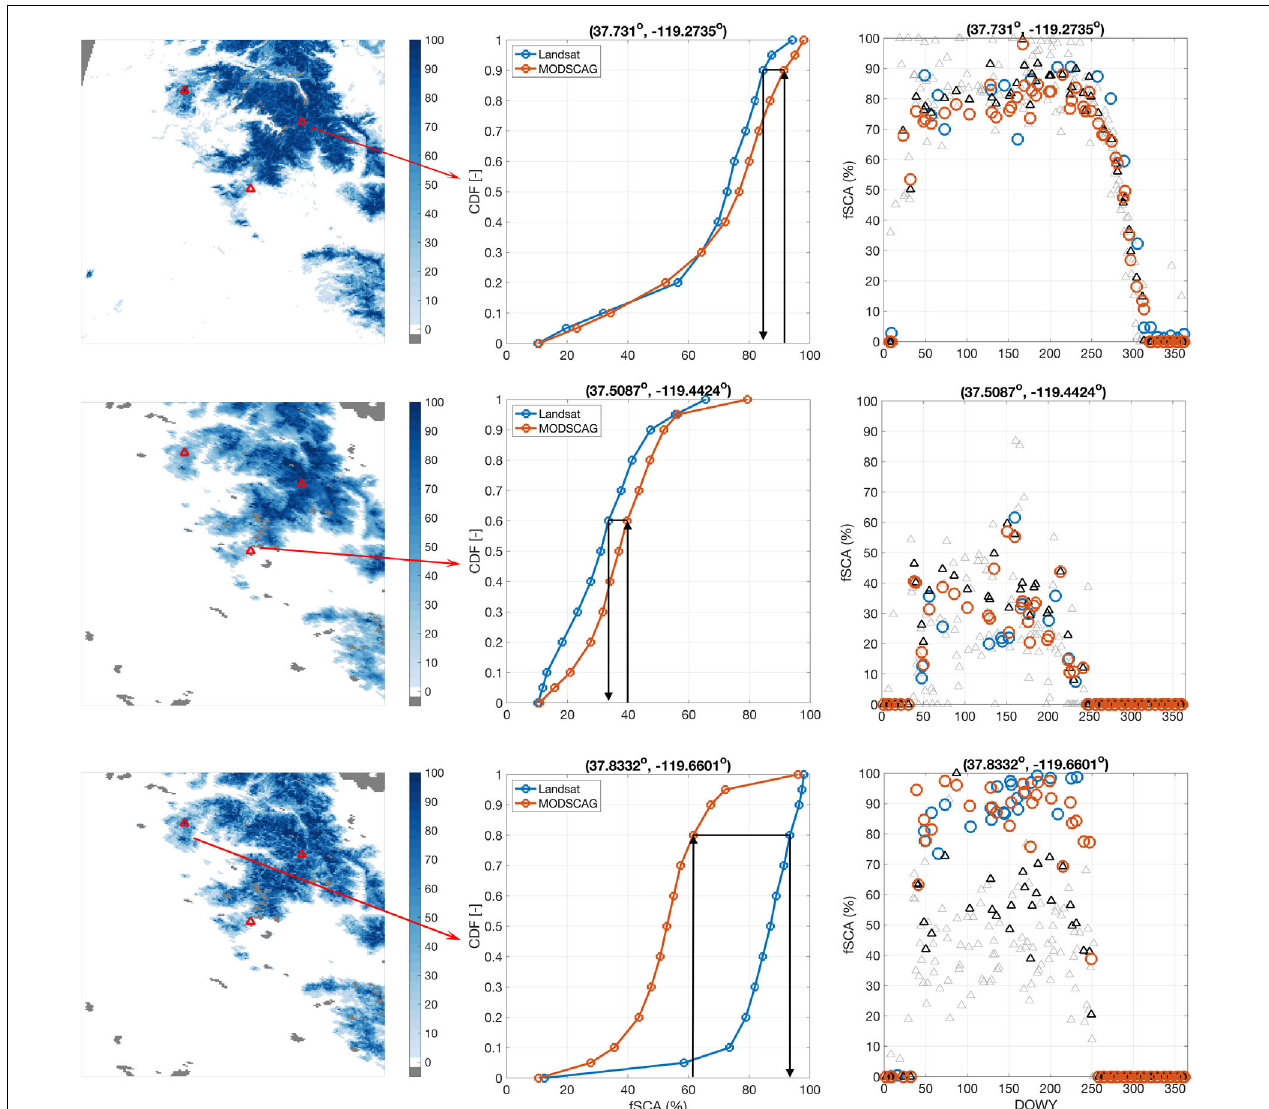
FIGURE 6 | (First column) Sample (WY 2016) images of fSCA estimates from Landsat (top) , raw MODSCAG (middle) and CDF-matched MODSCAG. (Second column) Empirical CDFs for: Landsat (blue) and screened (i.e., with viewing zenith angles θ < 20 ◦ ) MODSCAG (orange) for the three locations illustrated by red triangles in the first column . (Third column) Sample time series for WY 2016 for the three locations showing the: Landsat (blue), raw MODSCAG [black ( θ < 20 ◦ )/gray ( θ > 20 ◦ ) triangles], and CDF-matched MODSCAG corresponding to screened measurements (orange circles). The open circles (i.e., Landsat and screened/CDF-matched MODSCAG) are those measurements that are assimilated in the snow reanalysis